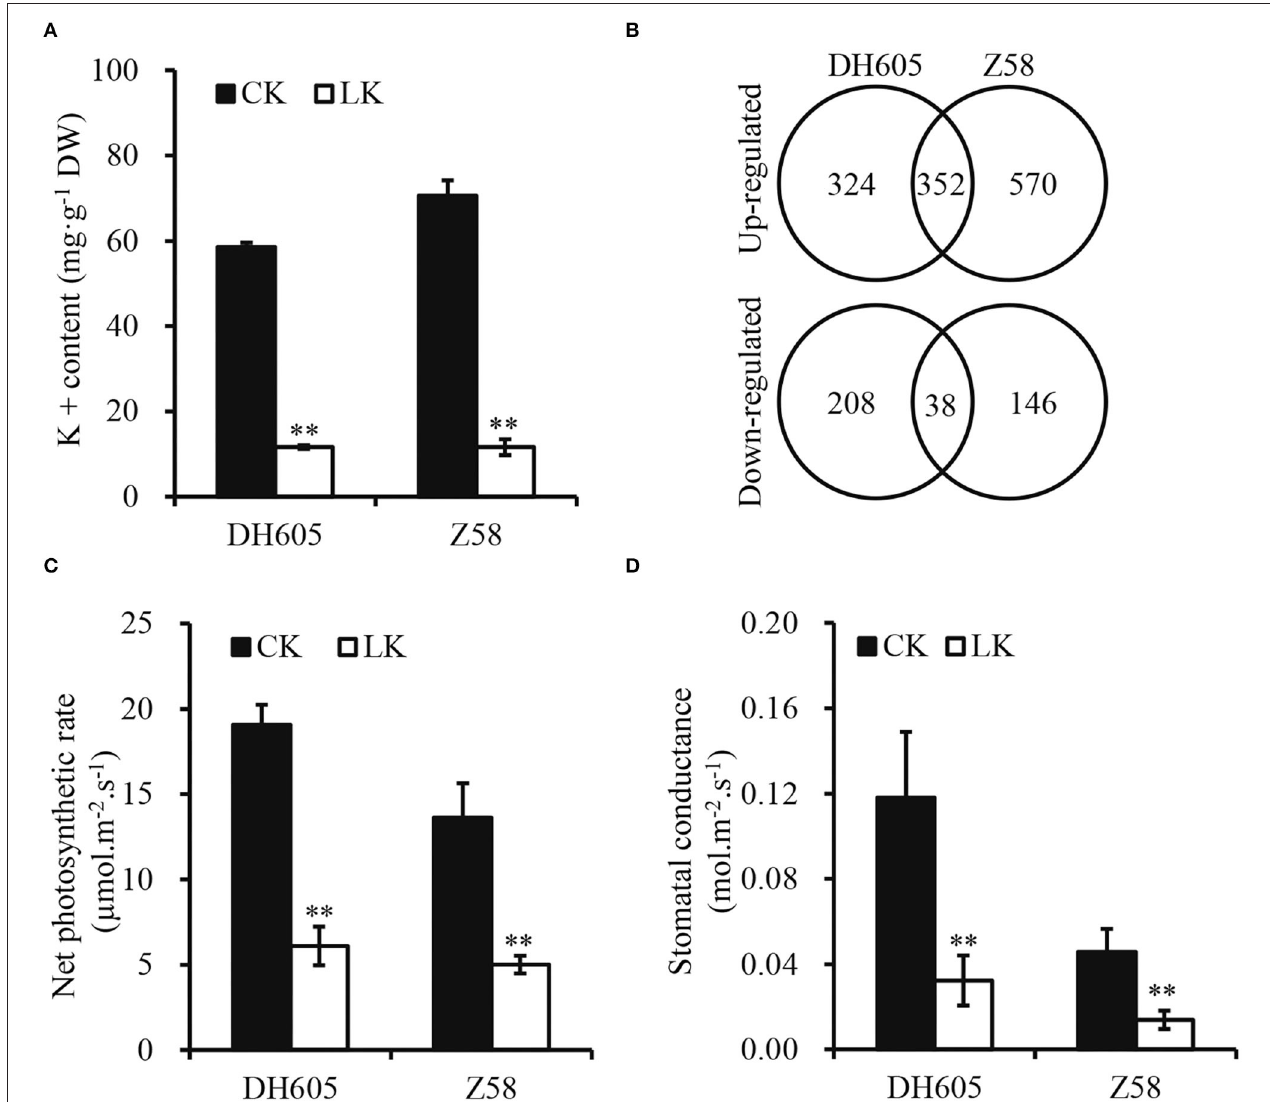
FIGURE 2 | Shoot potassium content (A) , differential expression genes (B) , leaf net photosynthetic rate (C) , and stomatal conductance (D) of maize DH605 and Z58 under K + deficiency treatment. CK and LK represent K + sufficiency (4mM) and K + deficiency (0.1mM), respectively. The experiments were repeated three times. ** on histograms mean the significant difference at the p ≤ 0.05 and p ≤ 0.01 level, respectively. Bars mean